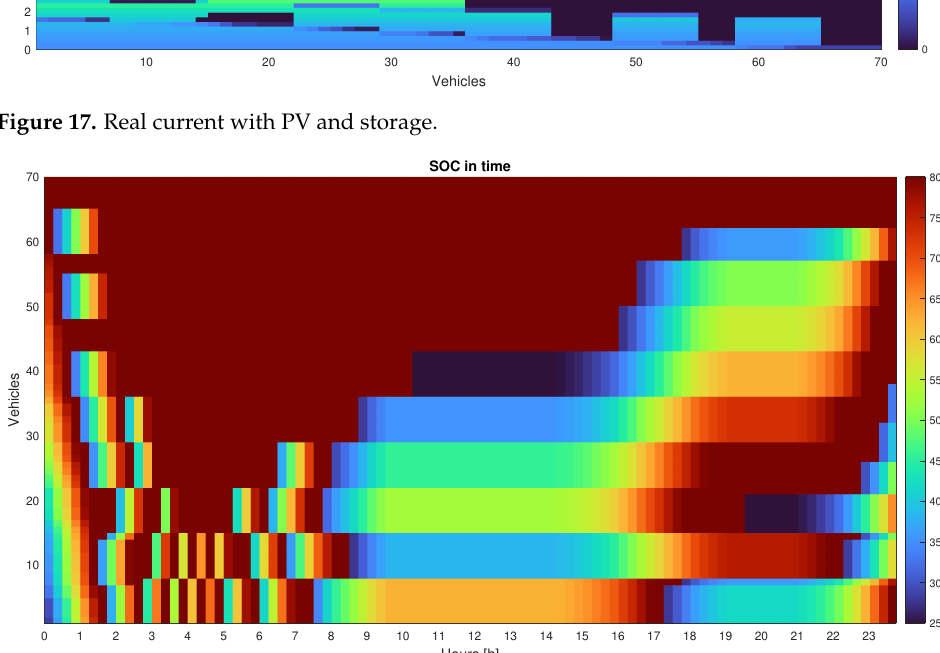
Figure 18. Real SoC % with PV and